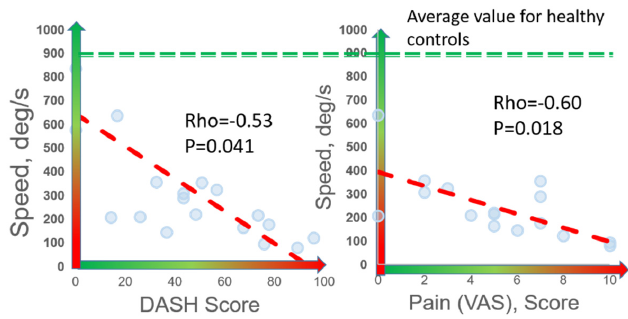
Figure 4. Correlation of digital biomarkers with PROMs. Among 16 nTOS patients, 7 digital biomarkers (shown here is speed) correlated with patient-reported disability (DASH) and pain (VAS).